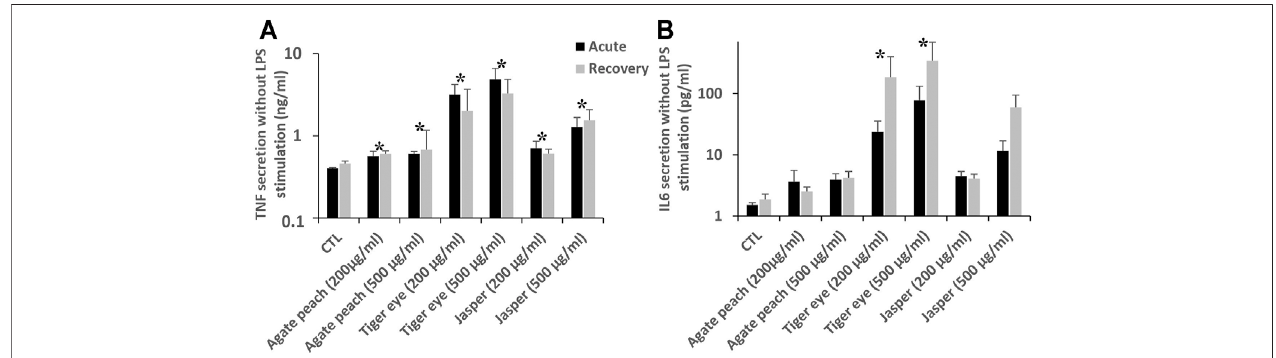
FIGURE6| IntrinsiccytokinesecretioninJ774A.1cellsafterexposuretopigmentcontainingsilica,followedornotbyarecoveryperiodof72 h.Blackbarsforacute exposureand grey bars forrecoveryprotocol. DataarerepresentedasMean +SD (A) TNF secretion (B) .IL-6 secretion All thetreated cellsaresigni fi cantlydifferentfrom the secretion of the control (Mann-Whitney statistic test, p < 0.05) in both acutely exposed cells and recovery scenario (N (cid:1) 4).